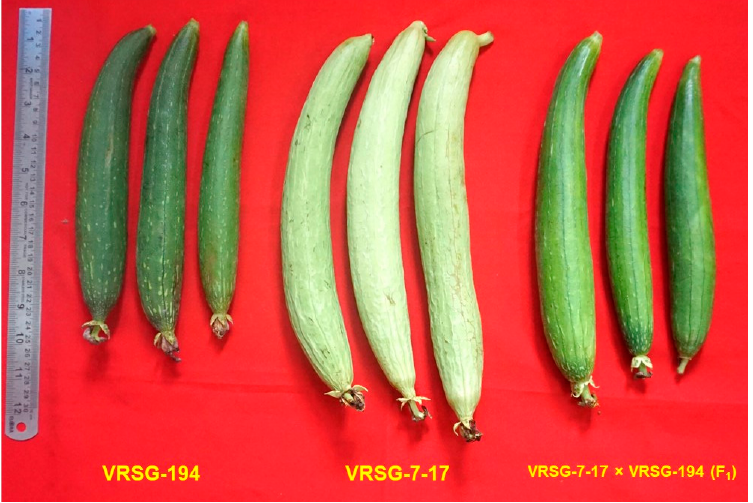
Figure 2. Fruits of parental lines VRSG-7-17, VRSG-194 and F 1 (VRSG-7-17 × VRSG-194) showing light green colour, dark green colour and green colour, respectively. Table 2. Observed segregation ratio and the Chi-square ( χ 2 ) value for the goodness-of-fit to mono- genic model (fruit colour) and digenic model (aroma and fruit colour) in an F 2 population derived from a cross between aromatic, light green and non-aromatic, dark green Luffa lines.